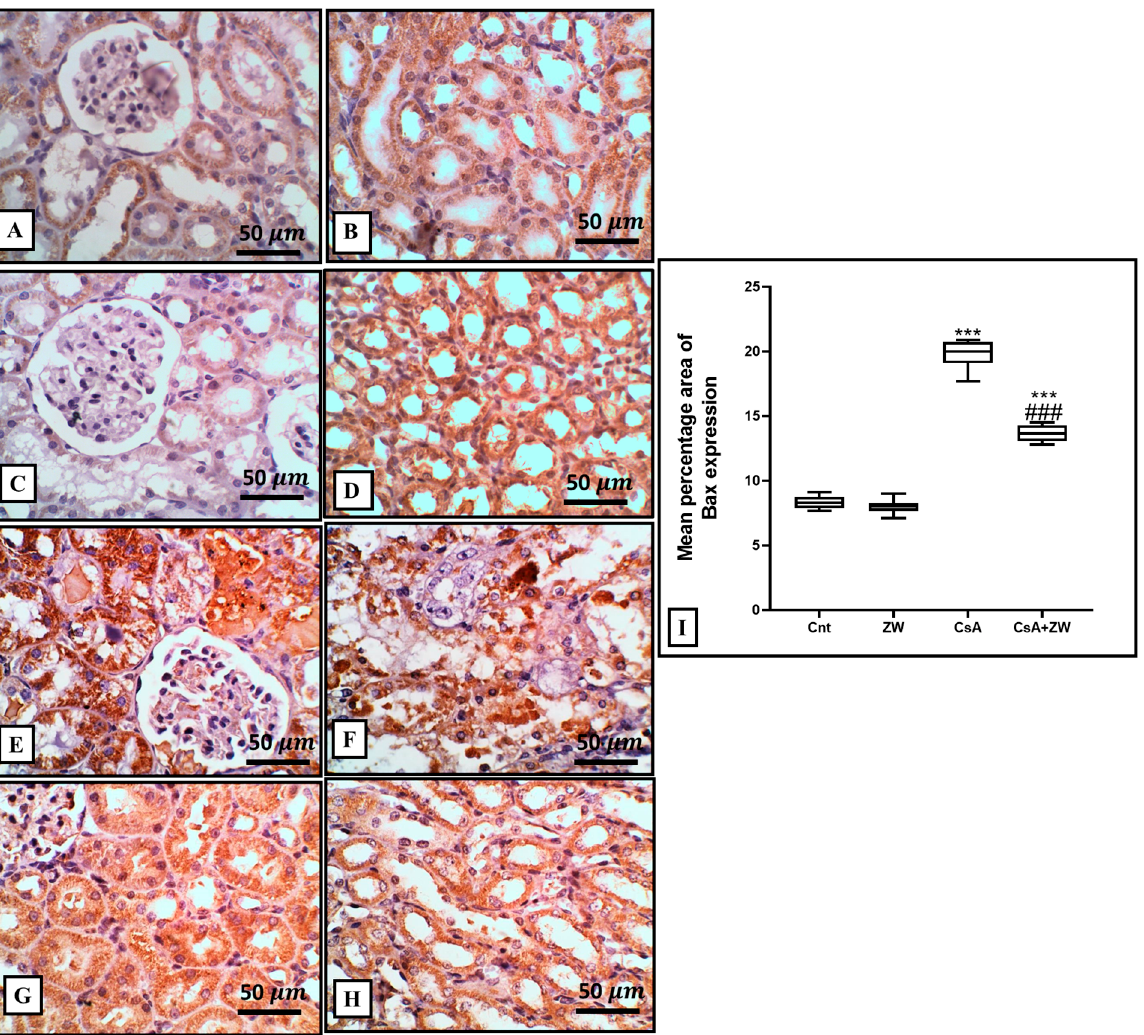
Figure 3. Bax immunohistochemistry of the kidney. ( A – D ) The control and ZW groups show faint cytoplasmic Bax expression in normal cortical and medullary tubules. ( E , F ) The CsA group shows di ff use severe and strong Bax expression in the cytoplasm of necrotic, sloughed tubular cells and vacuolated cells. ( G , H ) The CsA + ZW group shows di ff use moderate Bax expression in cortical and medullary tubules. ( I ) Histogram of the percentage area of the immunostaining of renal Bax. *** p <0.001vs. control ; ### p < 0.001vs. CsA. Image magni fi cation = 400×; scale bar = 50 µm.